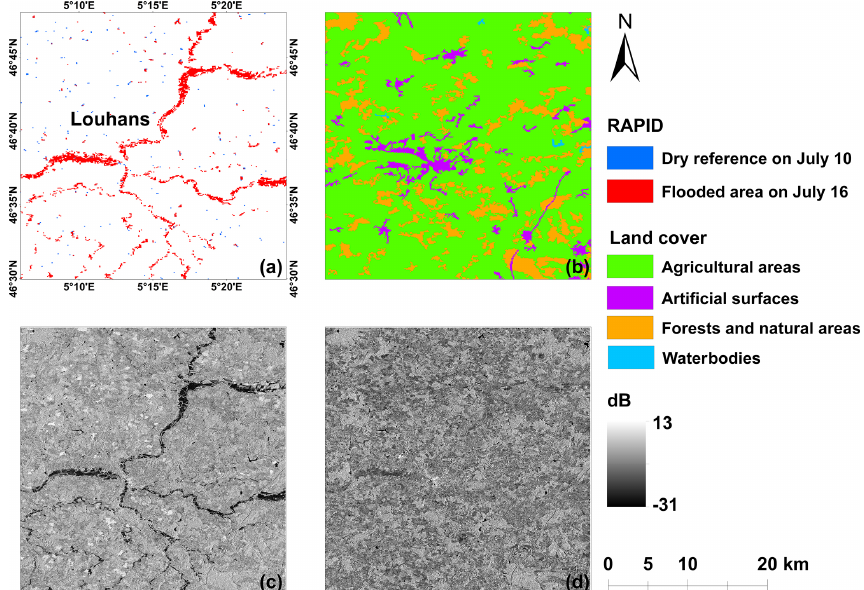
Figure 1. (a) RAPID flood map; (b) CORINE Land Cover map; (c, d) Sentinel-1 SAR image in VH polarization sensed on 16 (c) and 10 (d)